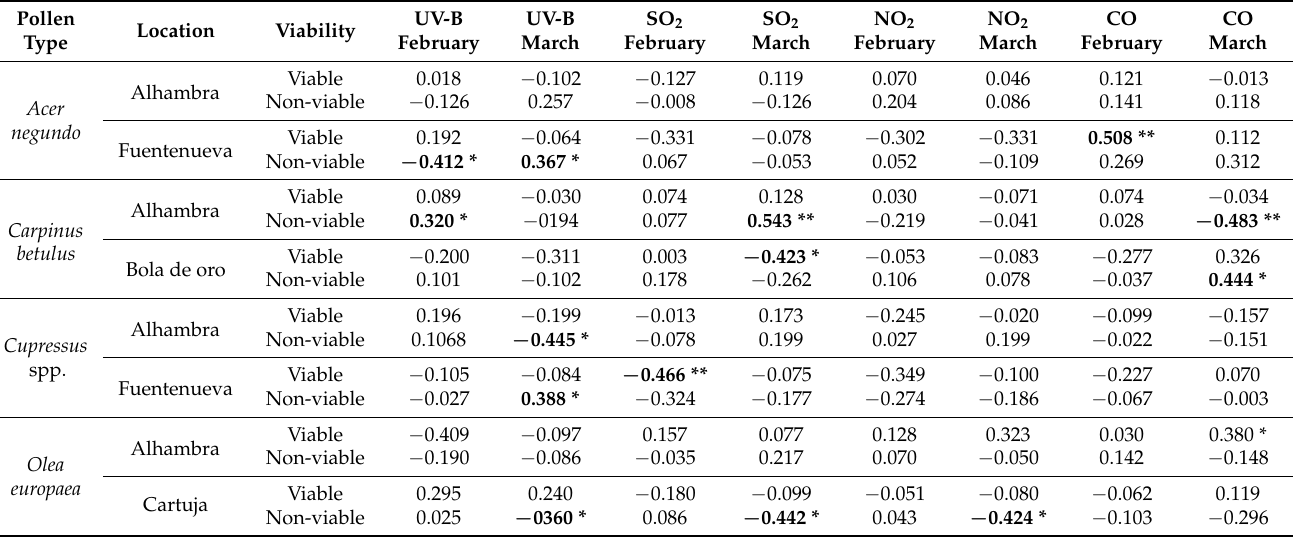
Table 5. Spearman’s correlation analysis between the percentage of viable and non-viable pollen (Trypan blue) and the concentrations of atmospheric pollutants during the pre-flowering and flowering periods.